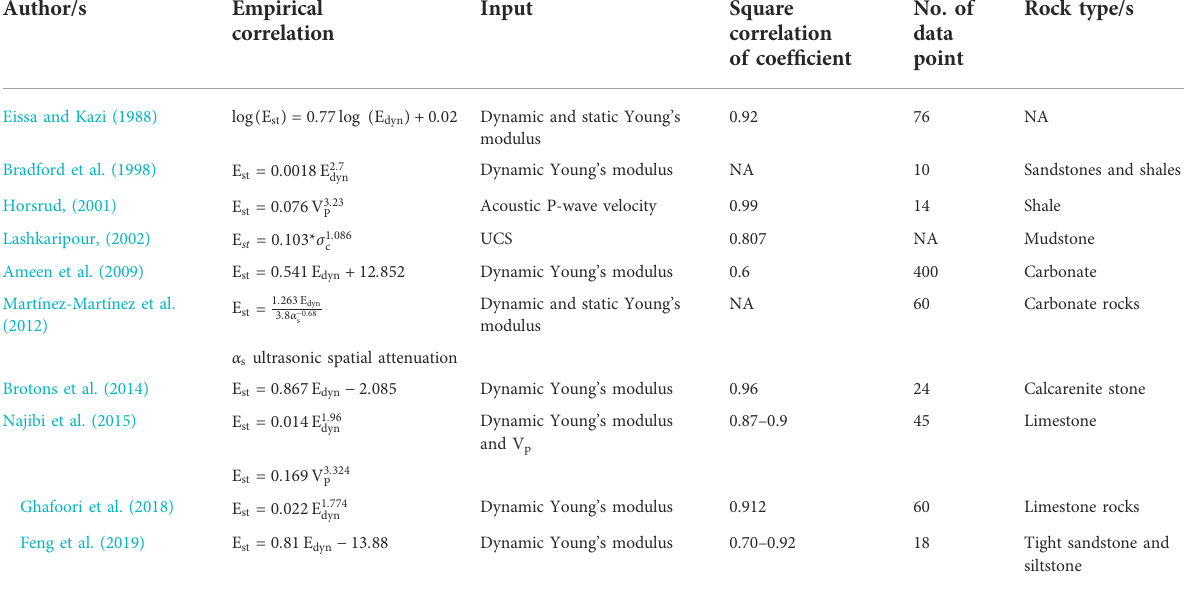
TABLE 1 Different correlations suggested by previous studies for E st estimation.